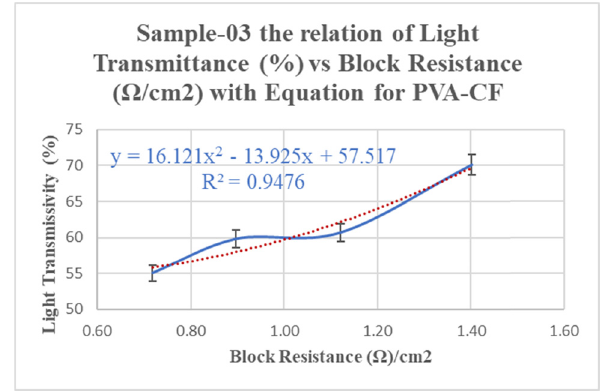
Figure 23: Sample - 03 ( CF:PVA = 0.3:30 ) light transmittance ( % ) versus block resistance ( Ω ) with equation for PVA - CF. The dotted lines represent the polynomial fi tted curve and the linear fi tted line.